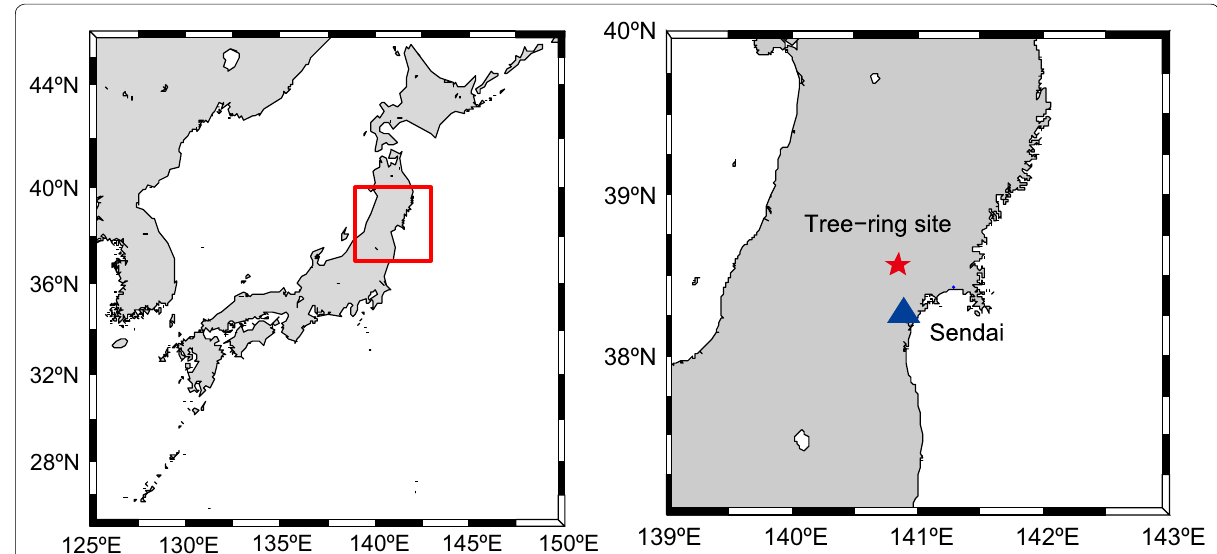
Fig. 1 Map of northeast Japan showing the tree-ring sample site and meteorological station (Sendai). Red star indicates the tree-ring site, and blue triangle shows